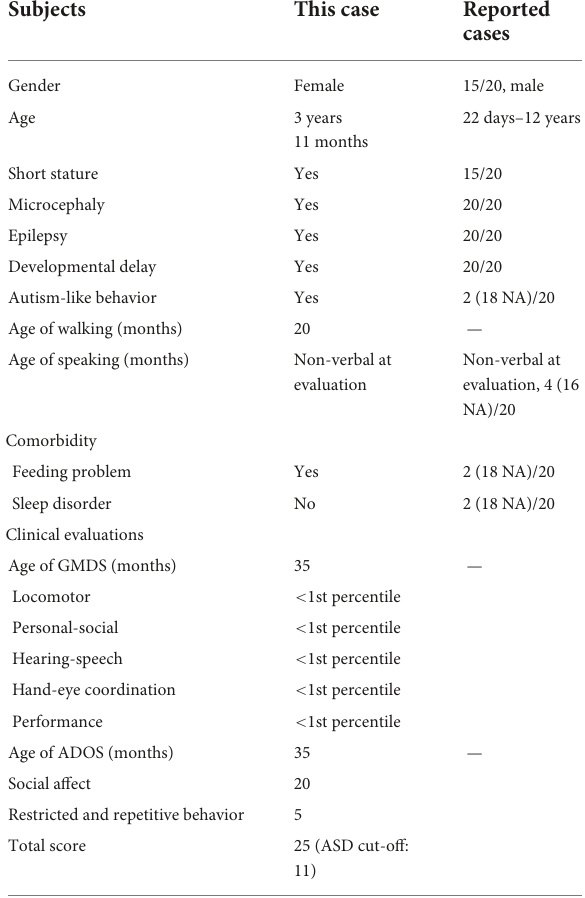
TABLE 1 Summary of STAMBP mutant patients’ early development and evaluation results.